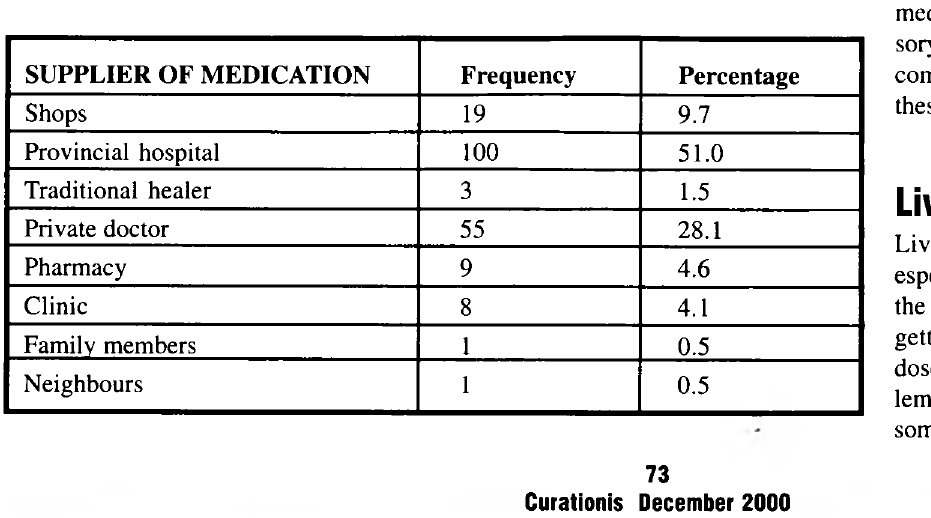
Table 1 : Supplier of medication (N=196)